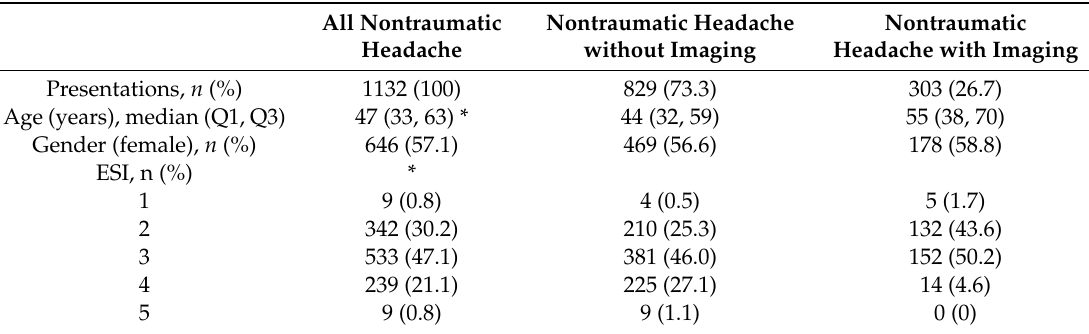
Table 1. Baseline